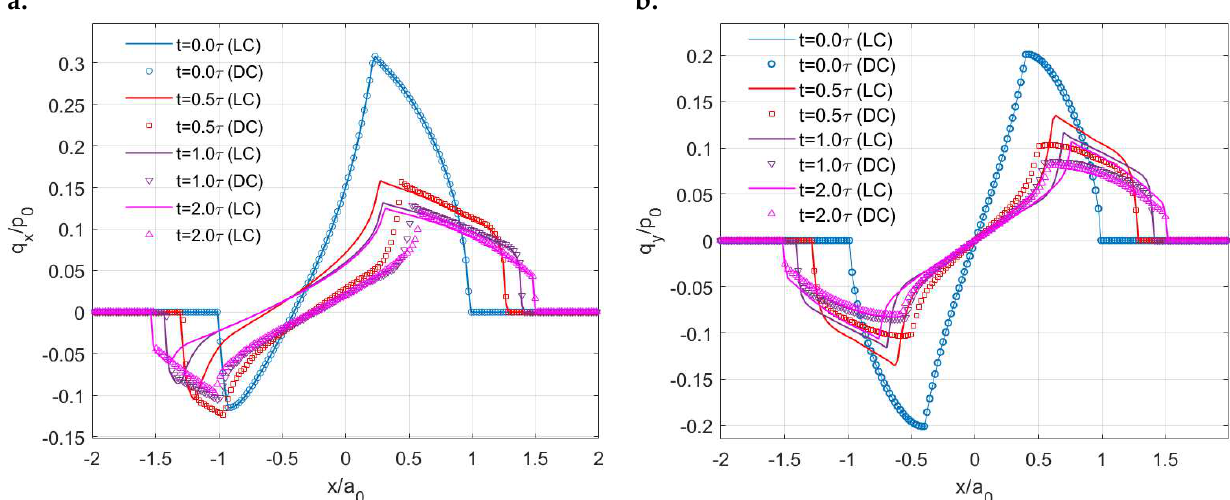
Figure 19. Changes in shear traction distribution with time in the LC (solid line) and DC (scatter plot) cases: ( a ) q x along the x axis and ( b ) q y along the y axis.